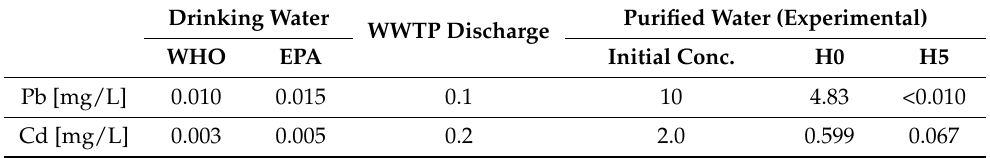
Table 7. Concentration of heavy metals after sorption. Concentration standards established by World Health Organization, United States Environmental Protection Agency, typical values for the Wastewater Treatment Plant discharge, results received in this study for raw halloysite (H0), and acid-treated